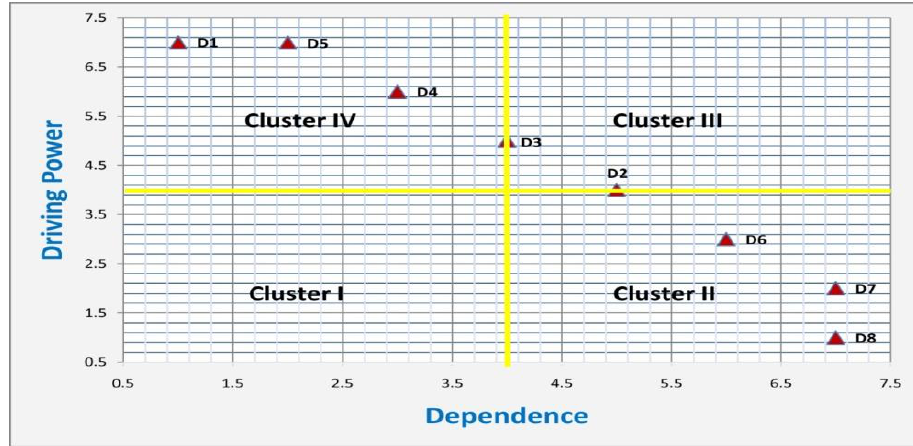
Fig. 3. MicMac analysis diagram.